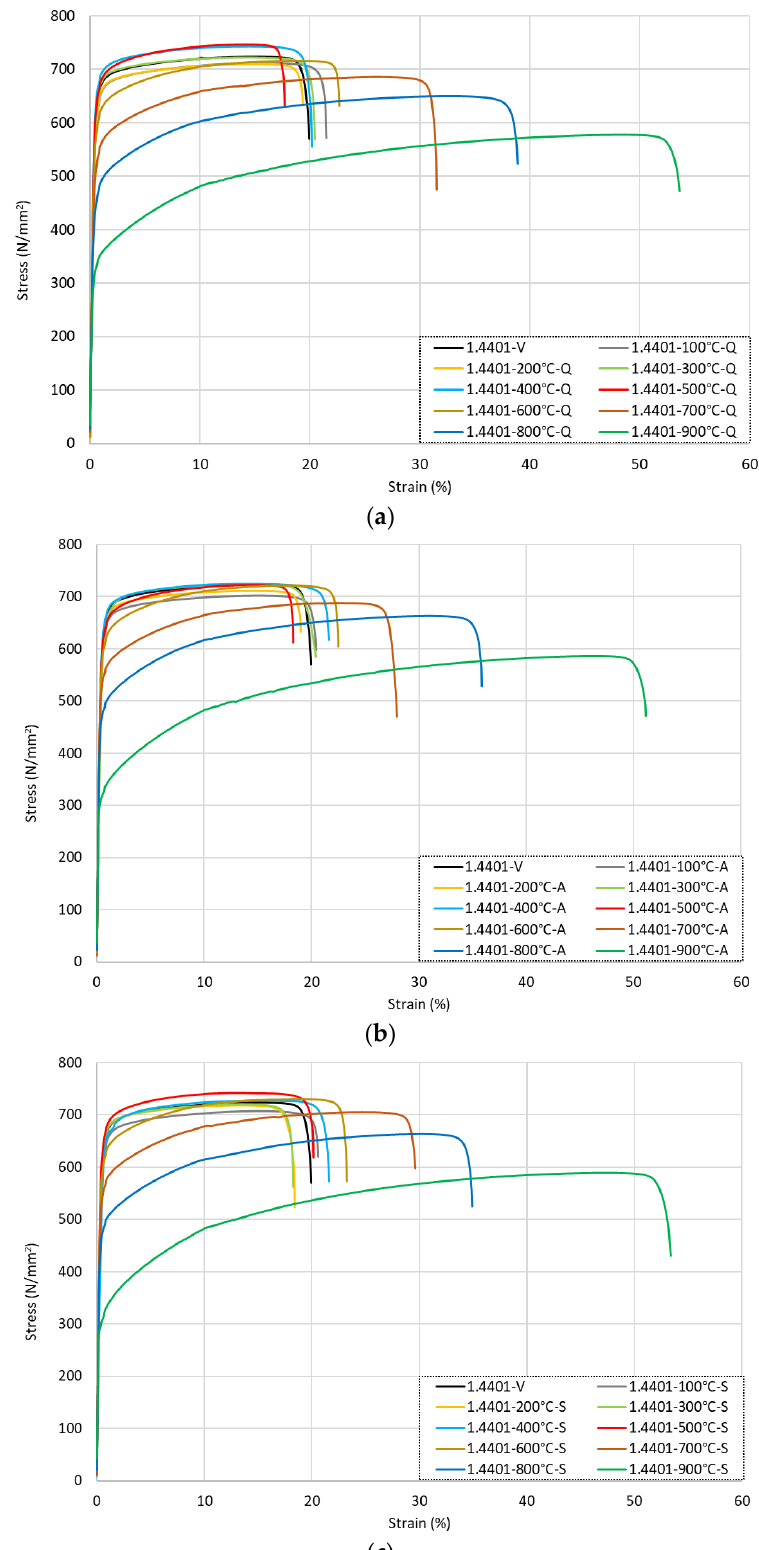
Figure 6. Stress–strain responses for grade 1.4401 stainless steel rebars following exposure to elevated temperatures and then ( a ) quenching in water, ( b ) cooling naturally in air, or ( c ) slow-cooling in the furnace.